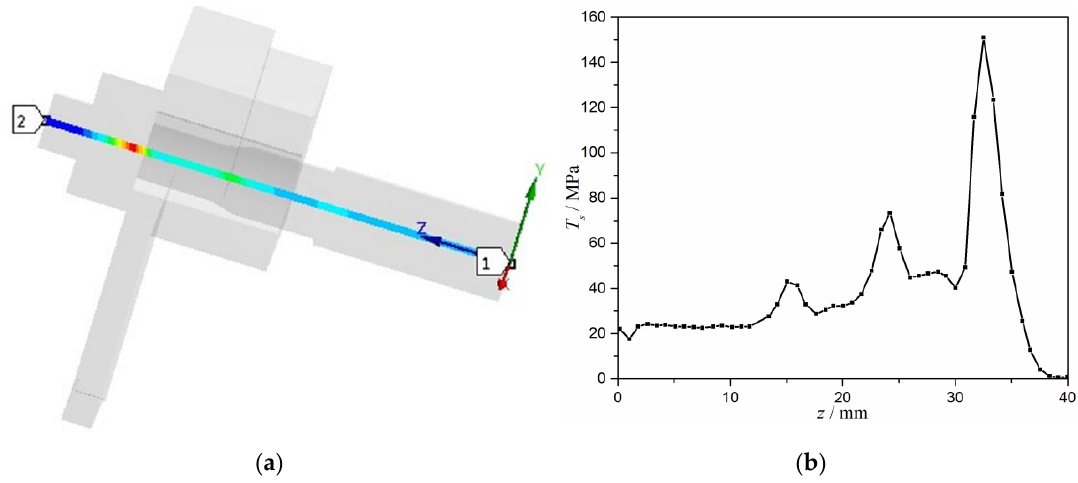
Figure 14. The path of the stress linearization analysis and the stress distribution along the path: ( a ) The path of the stress linearization analysis; and, ( b ) The stress distribution along the path.